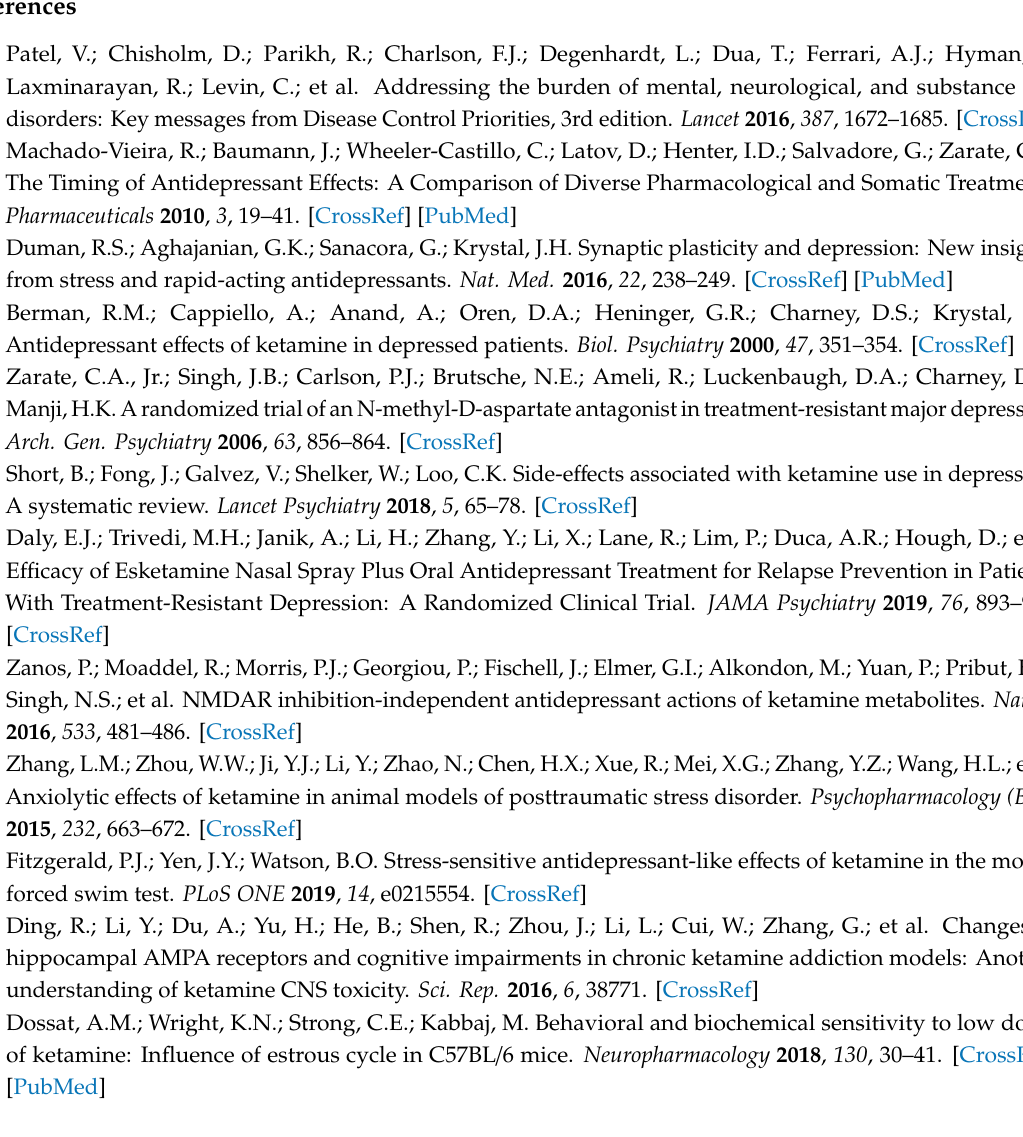
Figure A1. Ketamine and (2R,6R)-HNK did not affect olfaction of Arc-CreER T2 × CAG-Sun1/sfGFP mice. Olfaction in the bedding preference. Preference for dirty bedding was measured and is presented in percentage. Dotted line represents chance level. Male n = 22, female n = 39. All behaviors are expressed as mean percentage and error bars represent SEM. No effect of treatment or sex (two- way ANOVA).